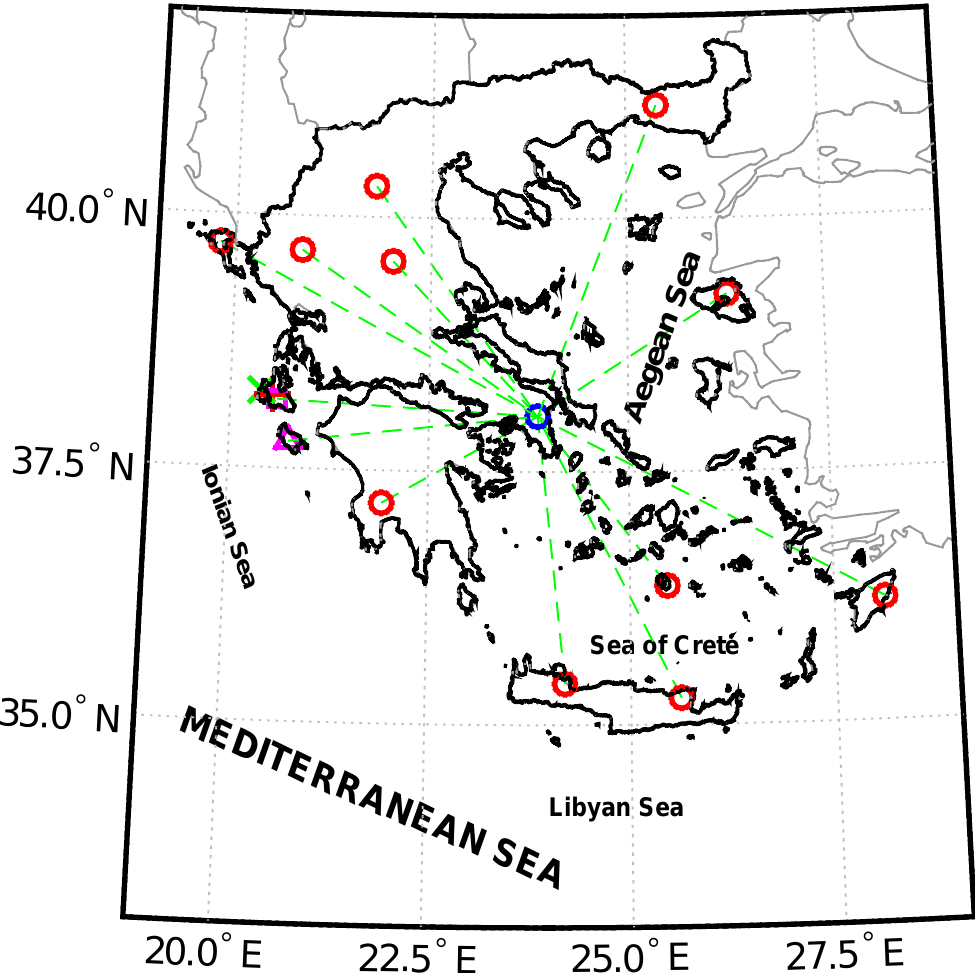
Figure 1. Map with the distribution of stations of the telemetric network that monitors electromagnetic variations in the MHz and kHz bands in Greece, which were operating during the time period of interest. The locations of the Cephalonia and Zante stations are marked by the magenta square and triangle, respectively, while the rest of the remote stations are denoted by red circles and the central data recording server by a blue circle. The epicentres of the two significant EQs of interest are also marked, the first (EQ1, M w = 6 . 0) by a red cross and the second (EQ2, M w = 5 . 9) by a green X mark. The electromagnetic variations monitored at the Zante station are 3kHz north–south, 3kHz east–west, 3kHz vertical, 10kHz north–south, 10kHz east–west, 10kHz vertical, 41, 54, and 135MHz, while at the rest of the stations, including the Cephalonia station, only the 3kHz north–south, 3kHz east–west, 10kHz north–south, 10kHz east–west, 41 and 46MHz are recorded. More details on the instrumentation of the telemetric network can be found in the supplementary downloadable material of Potirakis et al. (2015). (For interpretation of the references to colours, the reader is referred to the online version of this